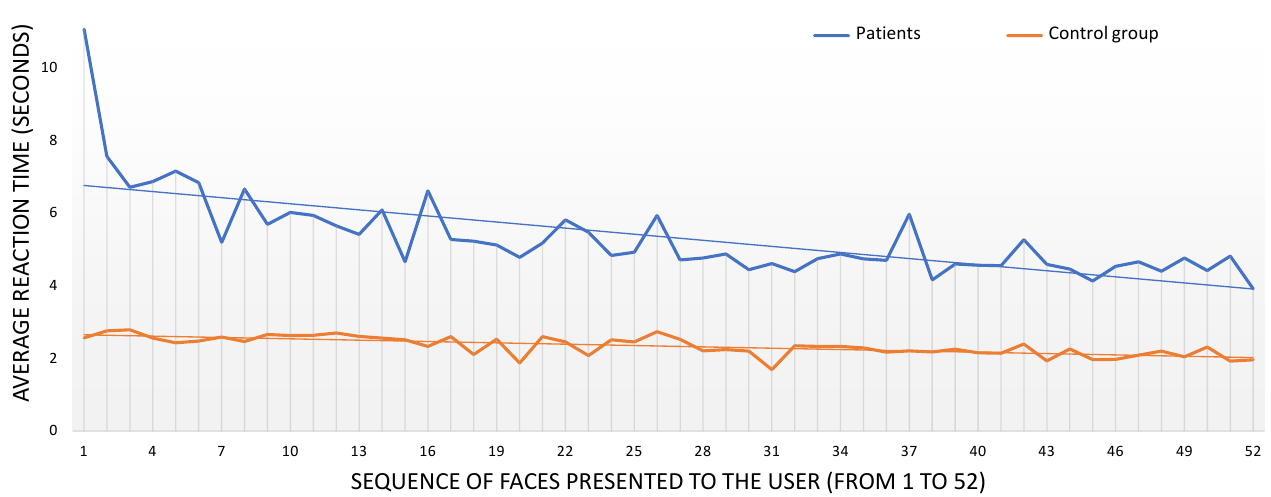
Figure 4. Average reaction time for each face presented to the users (y-axis). The x-axis refers to the sequence of 52 faces presented to the participants. The trend line shows a negative slope of 5.6% for the schizophrenia group and 1.2% for the control